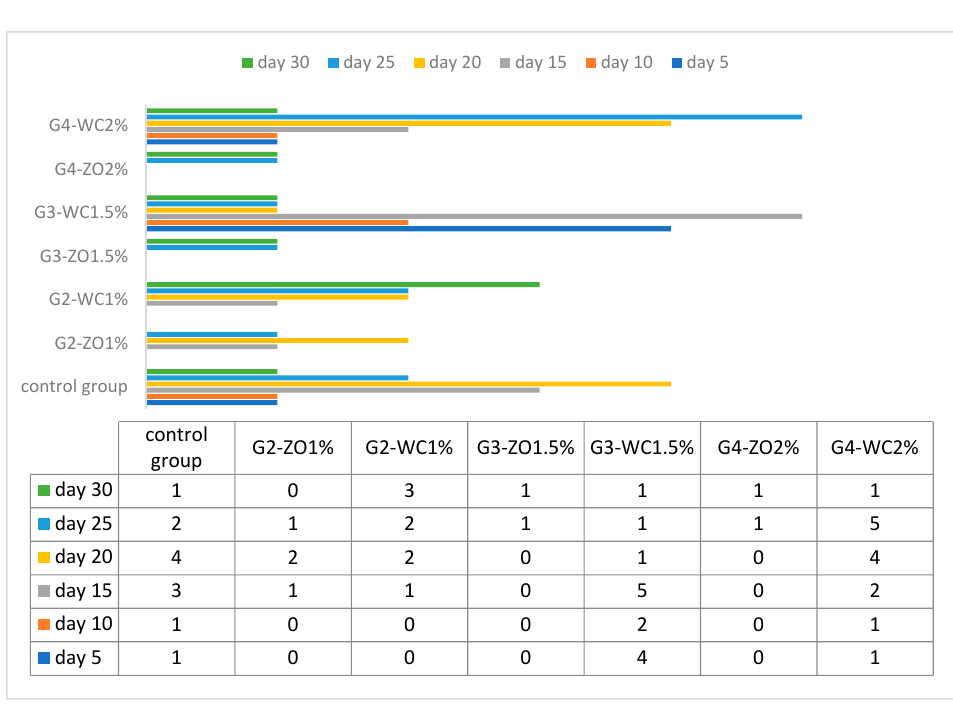
Figure 2. Mortality rate after challenge. The highest HA titer value was recorded for the group G2-ZO 1% (2 9 ) and G3-ZO 1.5% (2 9 ). The lowest value was found for G4-WC 2% (2 6 ). On the other hand, the highest value of ALP was obtained in G2-WC 1% (161.3 ± 0.4 b ) and G4-WC 2% (152.5 ± 0.7 d ). Details can be seen in Table 6. Table 6. Values obtained for ALP, HA titer, and Protein